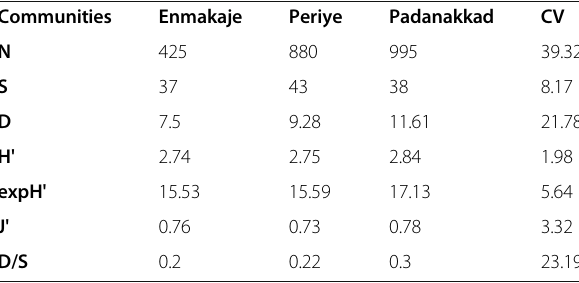
Table 1 Butterfly abundance ( N ), species richness ( S ), Simpson ’ s reciprocal index ( D ), the Shannon – Wiener index ( H ′ ), the exponential of the Shannon – Wiener index ( exp H ′ ), Pielou ’ s evenness ( J ′ ), and species evenness ( D/S ) calculated for 3 months of butterfly surveys completed within the three areas of study. Coefficient of variation ( CV ) is given for each metric